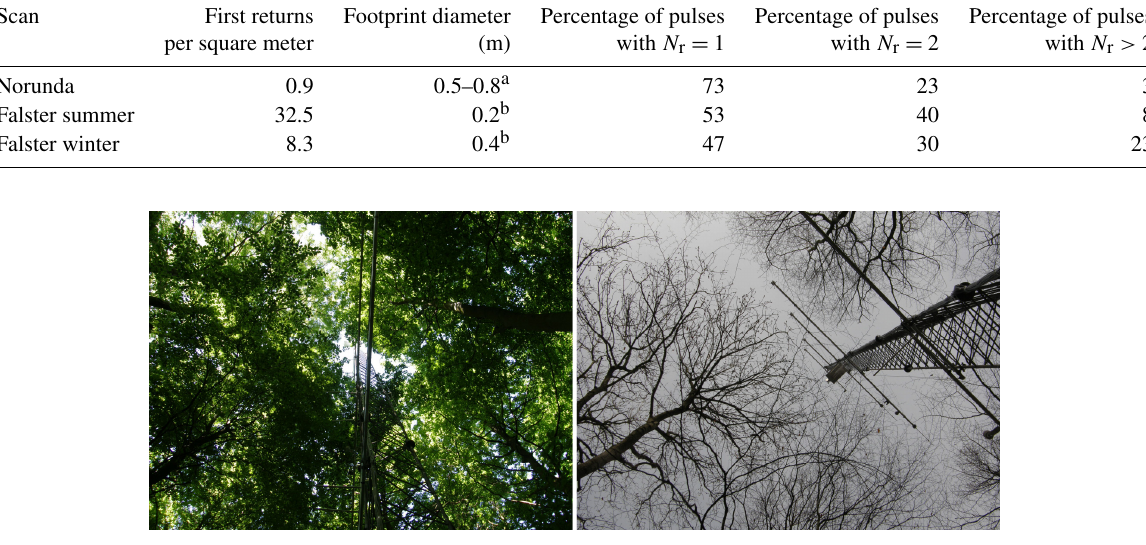
Figure 1. Photos taken at the position of the beech forest mast at the Falster site (Dellwik et al., 2014) illustrating the large difference between the summer (left) and winter (right)